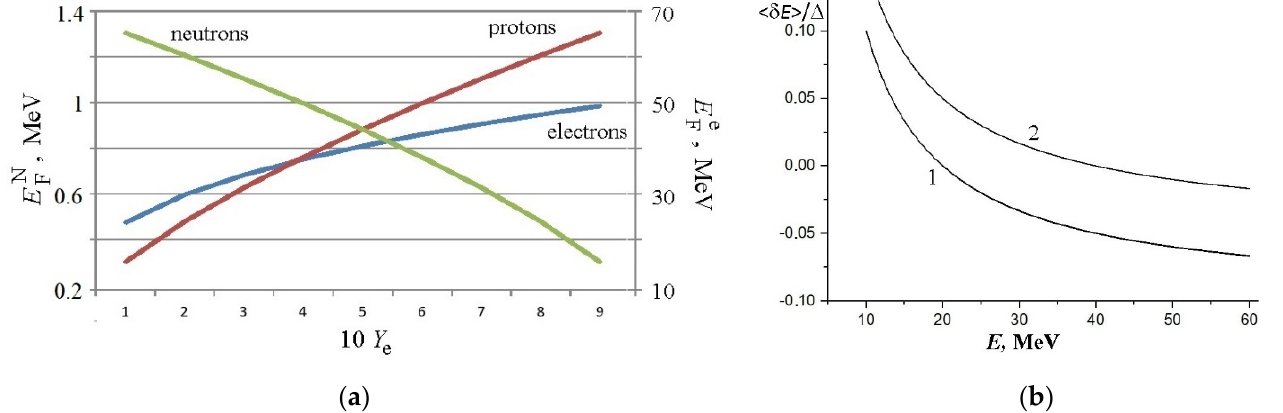
Figure 1. Neutrino sphere properties: ( a ) Fermi Energy at density n = 1 Tg cm − 3 versus beta equilibrium parameter Y e . ( b ) The neutrino energy dependence of an average transferred energy < δ E > during inelastic scattering at temperatures T = 5 and 10 MeV, corresponding to the curves 1 and 2. The approximate relationship in Equations (3) and (4) coincide within the line widths.